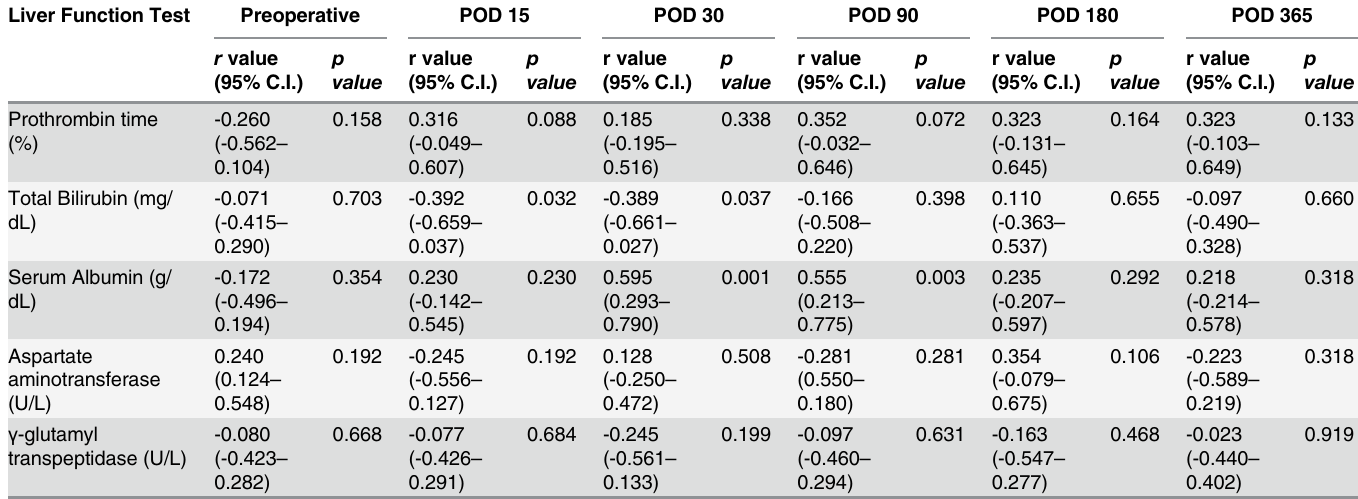
Table 2. Correlation analysis between main liver function tests and IGF-1 plasma levels at different time points. IGF-1, insulin-like growth factor 1; POD, postoperative day; C.I. confidence interval. Liver Function